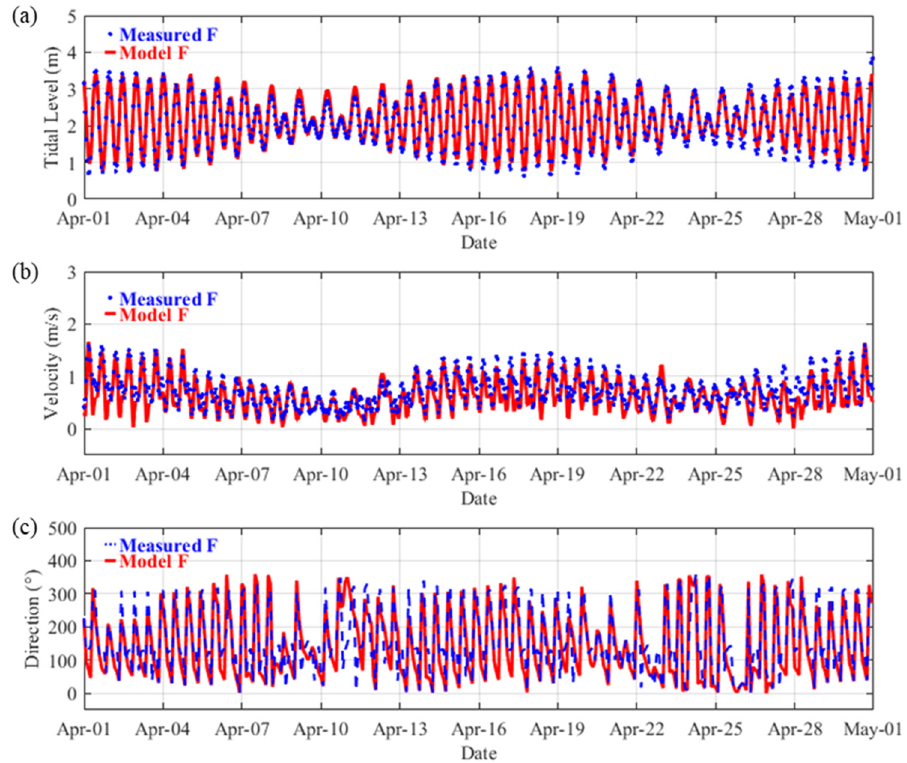
Figure 2. Verification of ( a ) water level, ( b ) current velocity and ( c ) direction (1–30 April 2018).